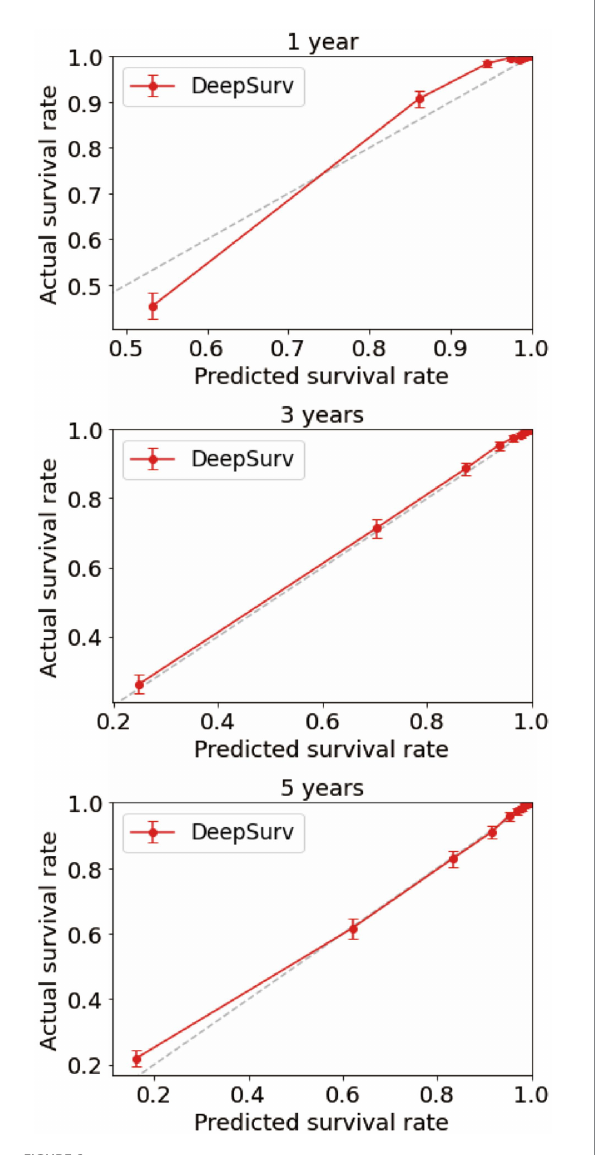
FIGURE 6 Calibration plots of survival rate of CMM in DeepSurv